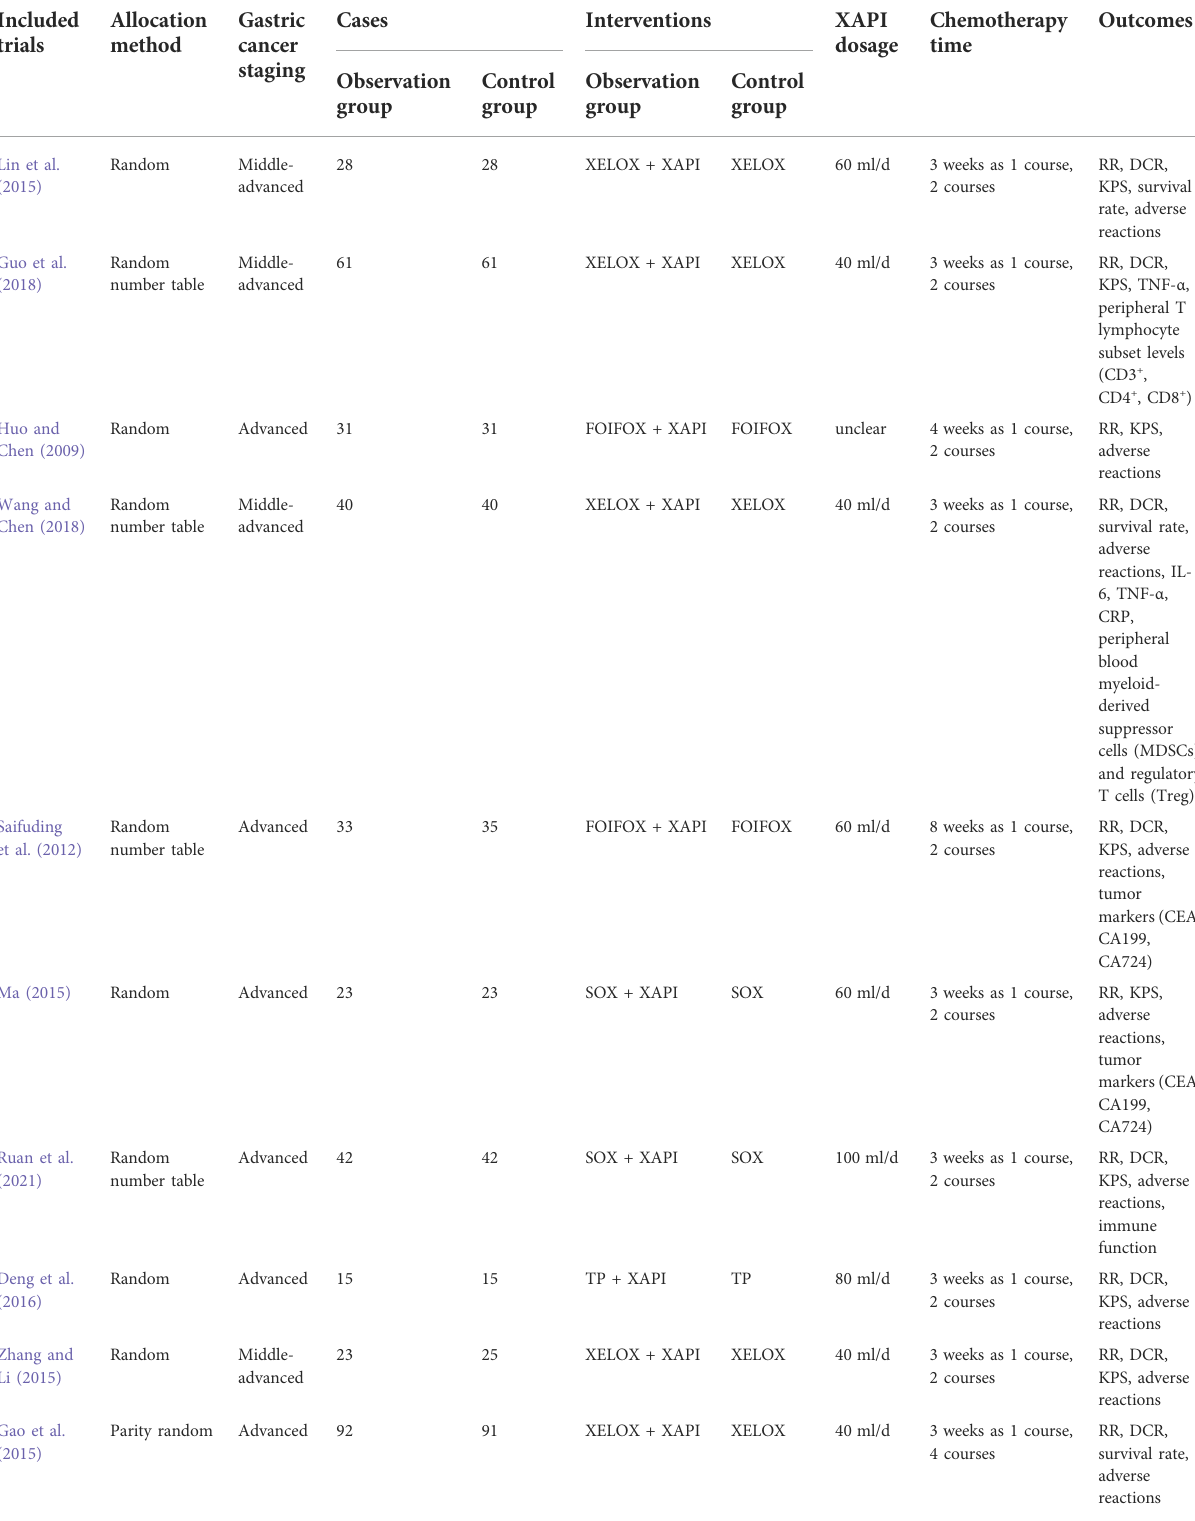
TABLE 1 Baseline information of included